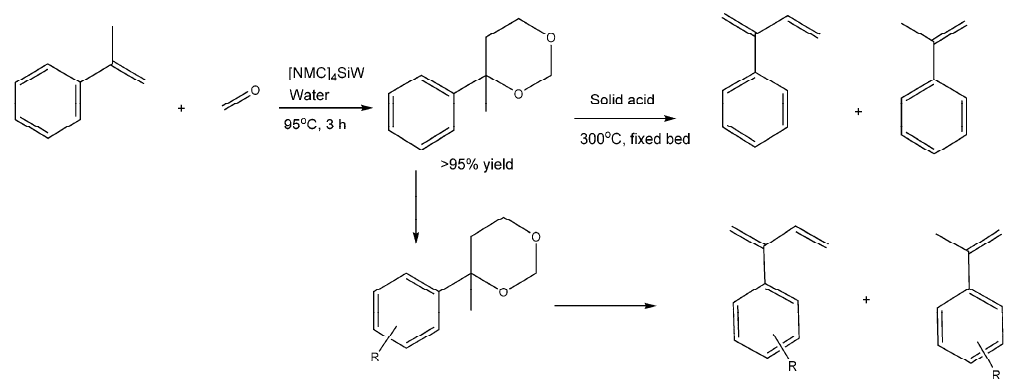
Figure 9. A straightforward way to synthesize 2-phenyl-1,3-butadiene [129].